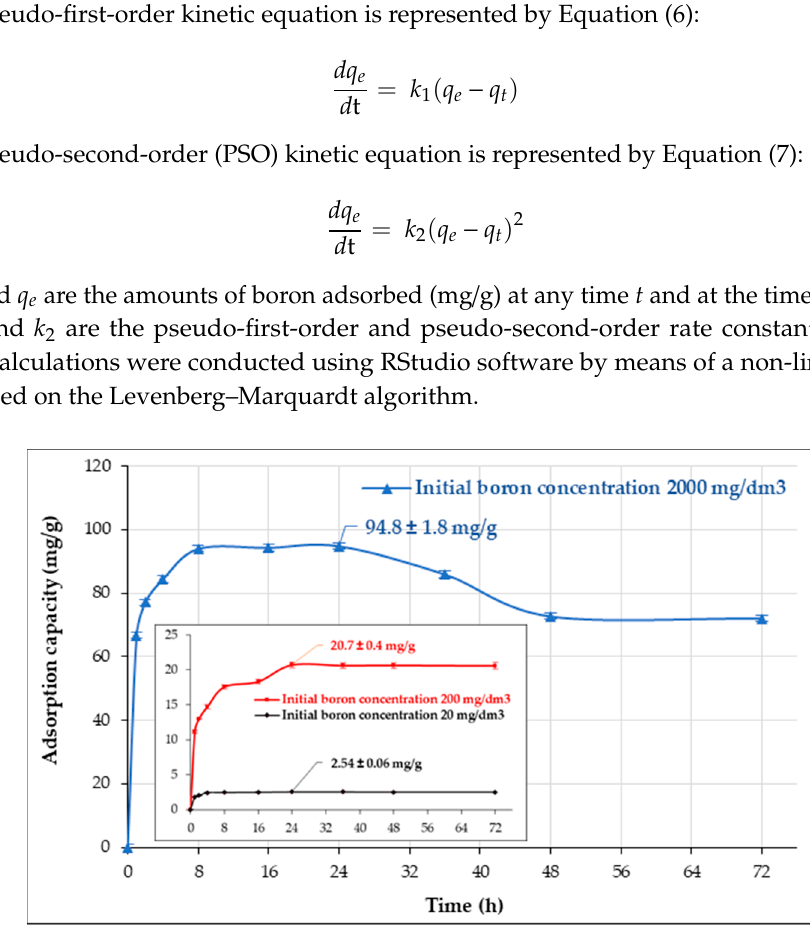
Figure 8. Effect of contact time on boron adsorption capacity of La-CTS hydrogel beads. The inserted figure is the effect of contact time when initial boron concentrations were 20 and 200 mg/dm 3 , respectively.